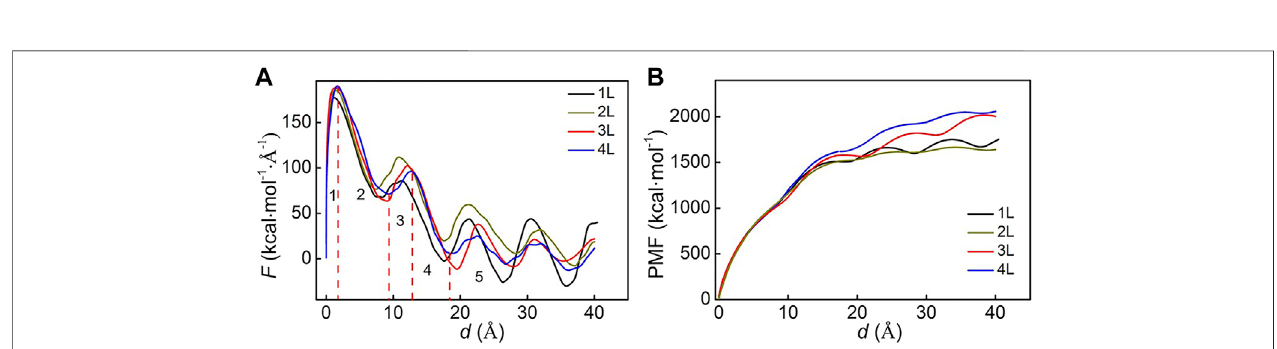
FIGURE 4 | (A) Pulling force curvesofthe sandwiched systems with different layers ofgraphene. Different fromthe force curveswithout coating,these curvescan be dividedinto fi vestages.Whentheforce fi rstreducestothelocalminima,itfollowsbyasmallincrementbeforedecreasingtoaboutzero.Thissmall fl uctuationiscausedbythe constraint release of the debonding between epoxy and graphene. (B) Corresponding PMF curves. The PMF reaches the local maxima when the force reduces to zero.